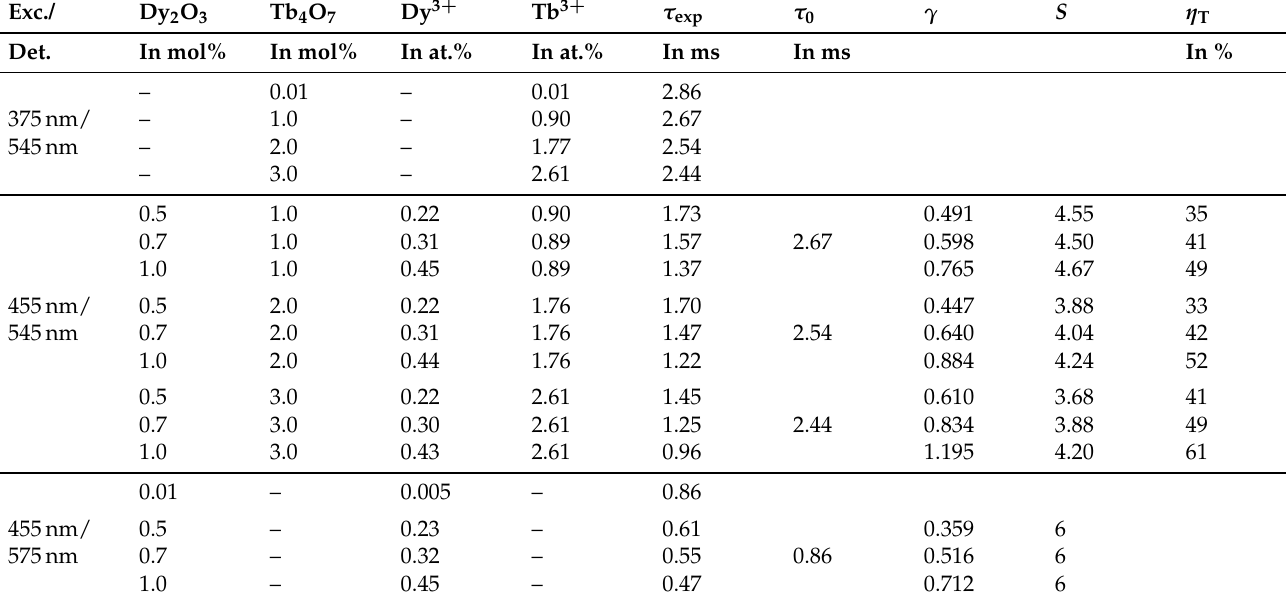
Table 3. Fit parameters obtained from an analysis based on the Inokuti–Hirayama model as well as the energy transfer efficiency calculated from the